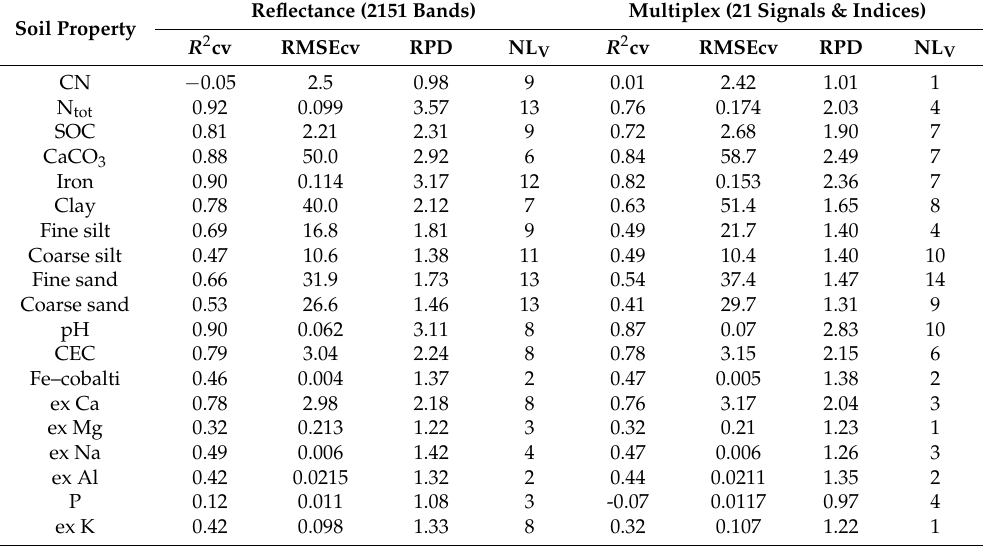
Table 7. Cross-validation performance statistics of PLSR algorithm for soil properties prediction (NL v , number of latent variables) from either laboratory reflectance (left) or Multiplex fluorescence (right) for all